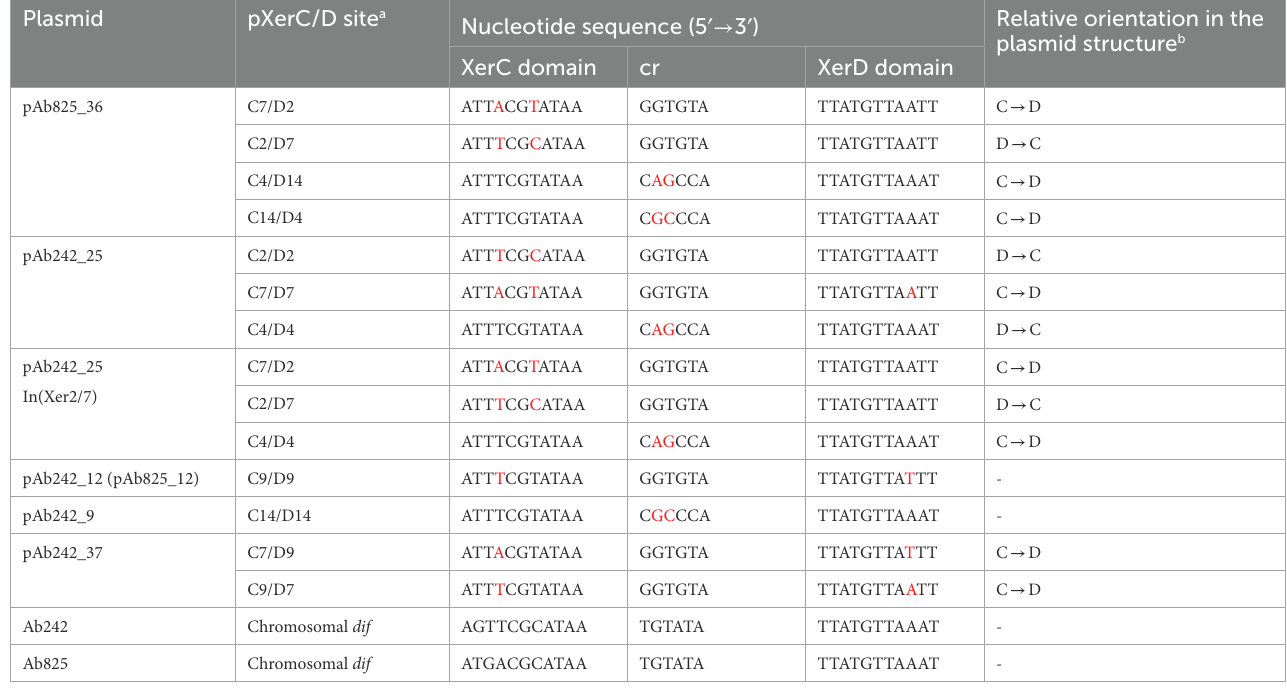
TABLE 1 pXerC/D core sequences found in the Ab825 and Ab242 plasmids studied in this work.